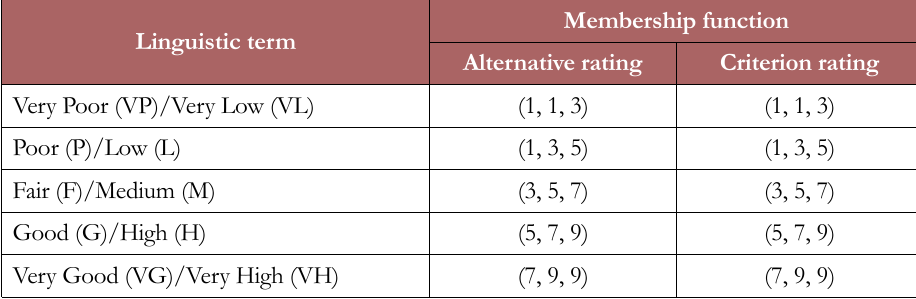
Table 5. Linguistic terms for alternatives and criteria